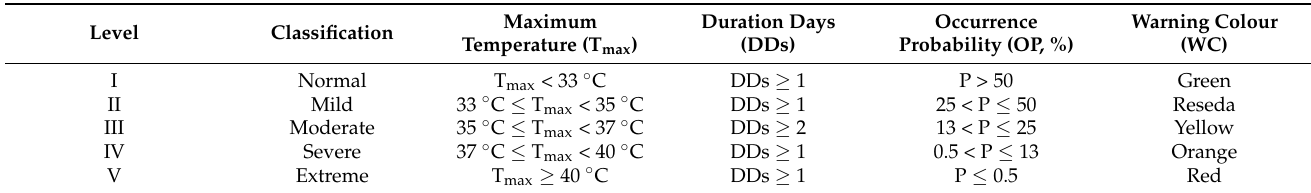
Table 1. Classification and criteria for heat stress on Huaibei Plain,